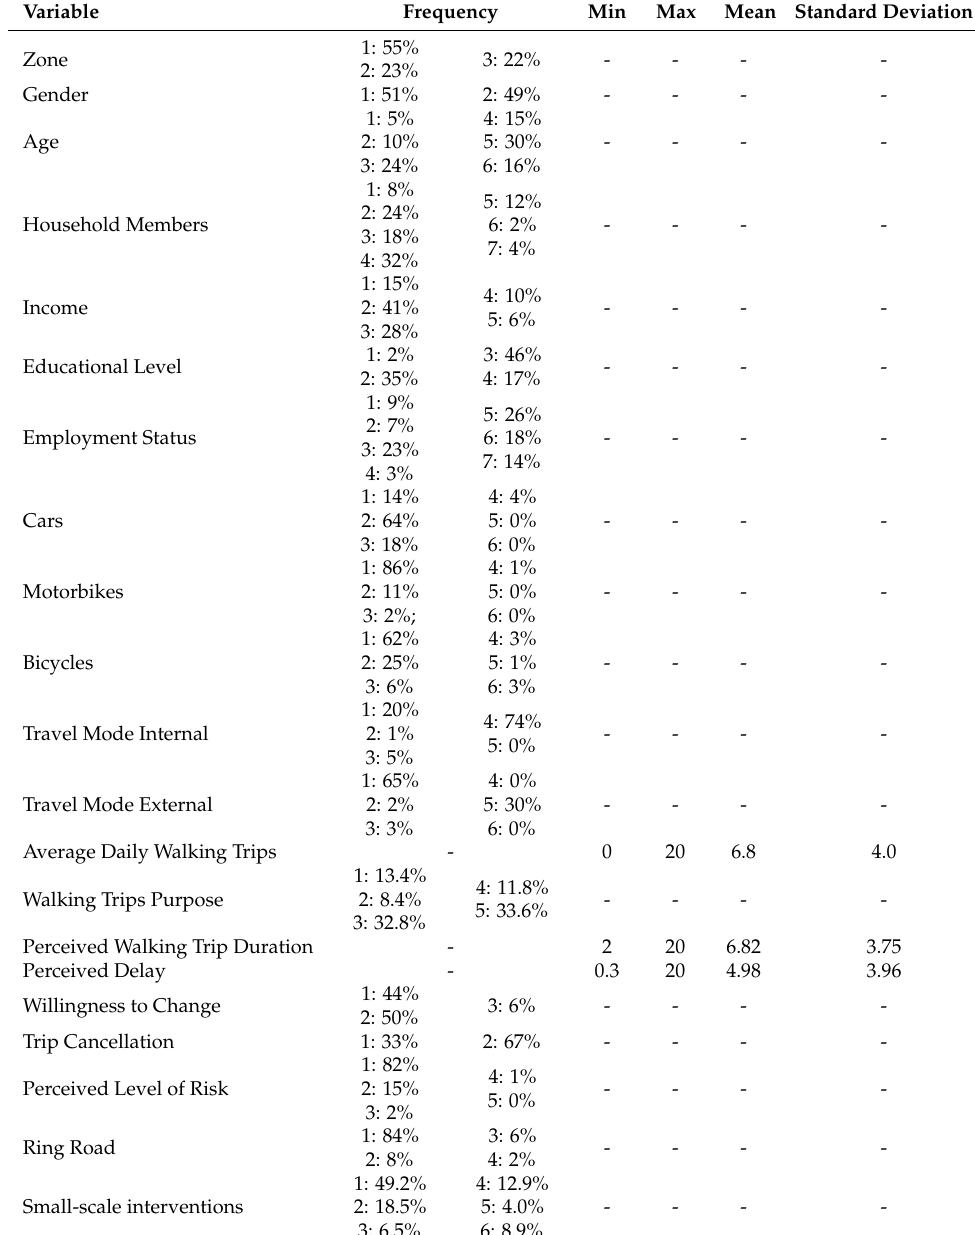
Table 2. Descriptive statistics of the variables